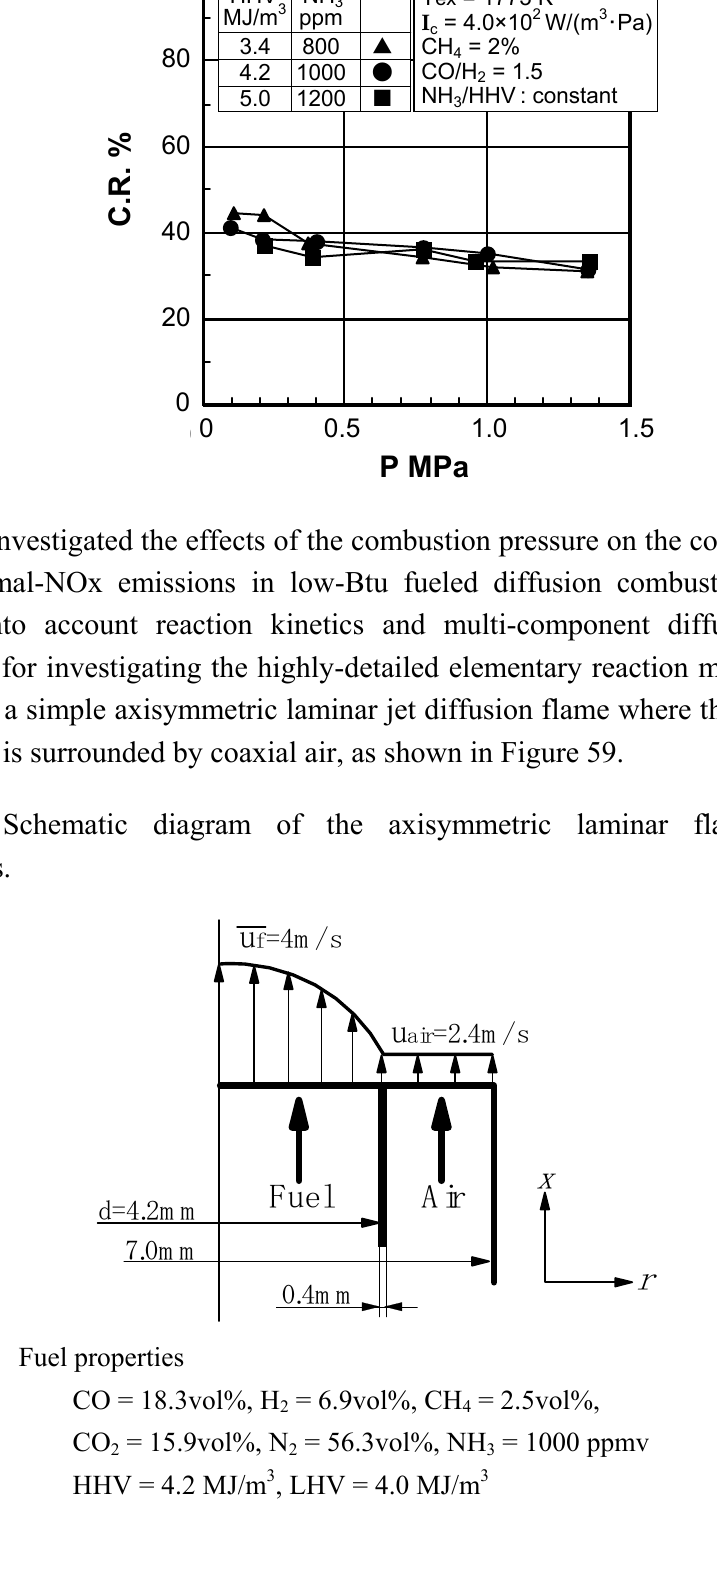
to NOx with fuel 3